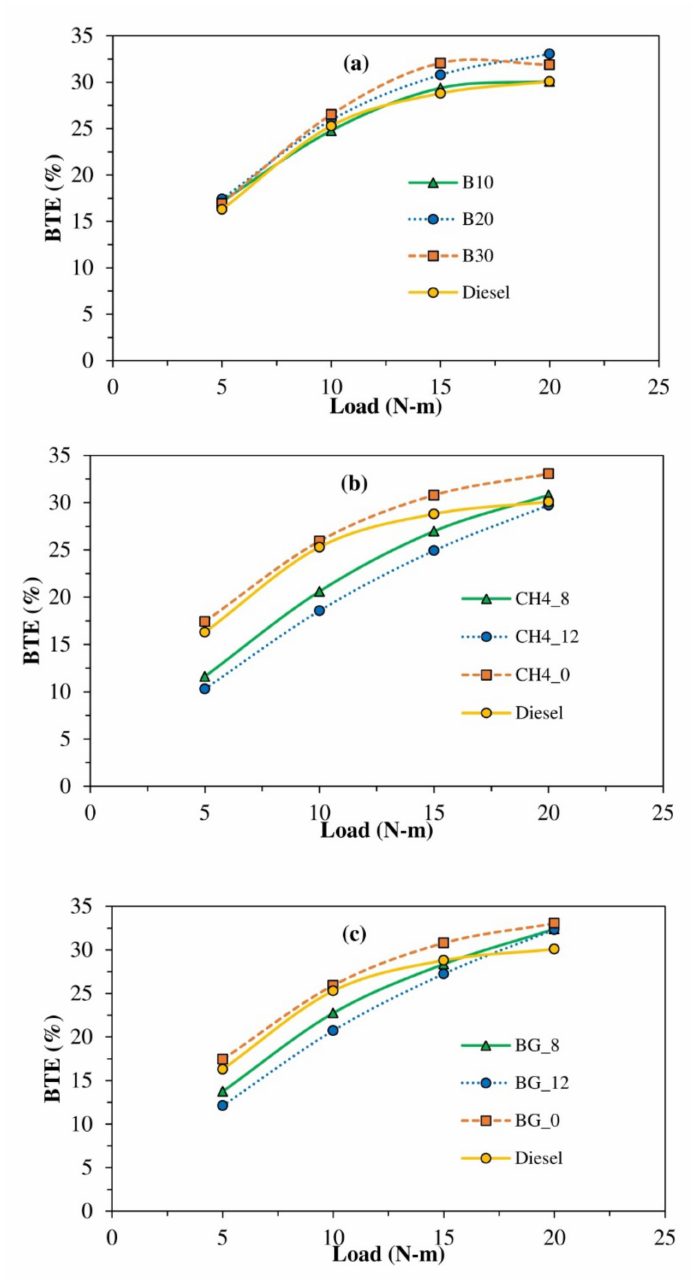
Figure 2. Variation of BTE with load at various ( a ) Mahua biodiesel blend, ( b ) methane flow rate and ( c ) biogas flow